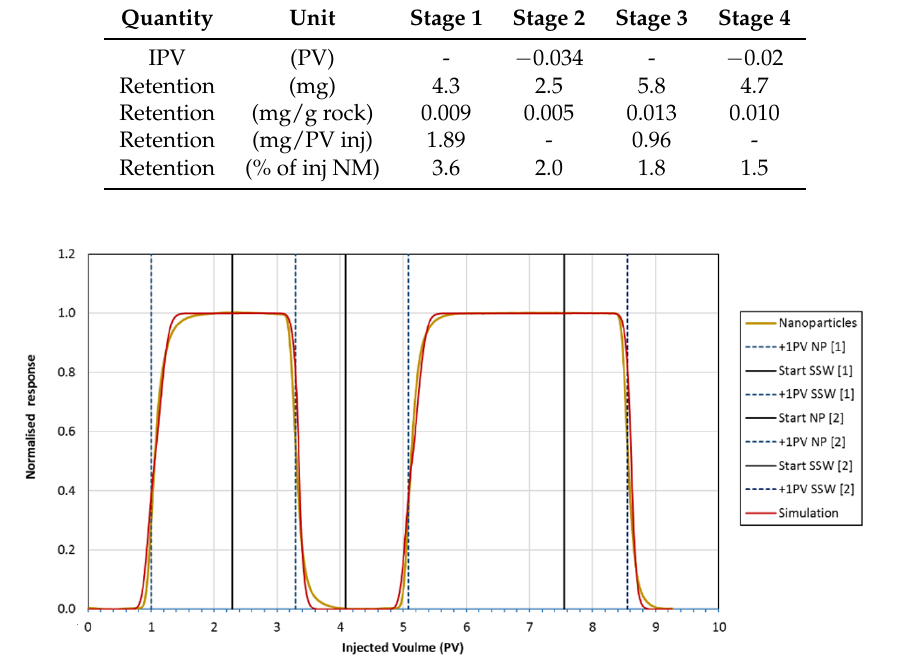
Table 7. Inaccessible pore volumn (IPV) and retention of nanomaterials during Experiment 1.